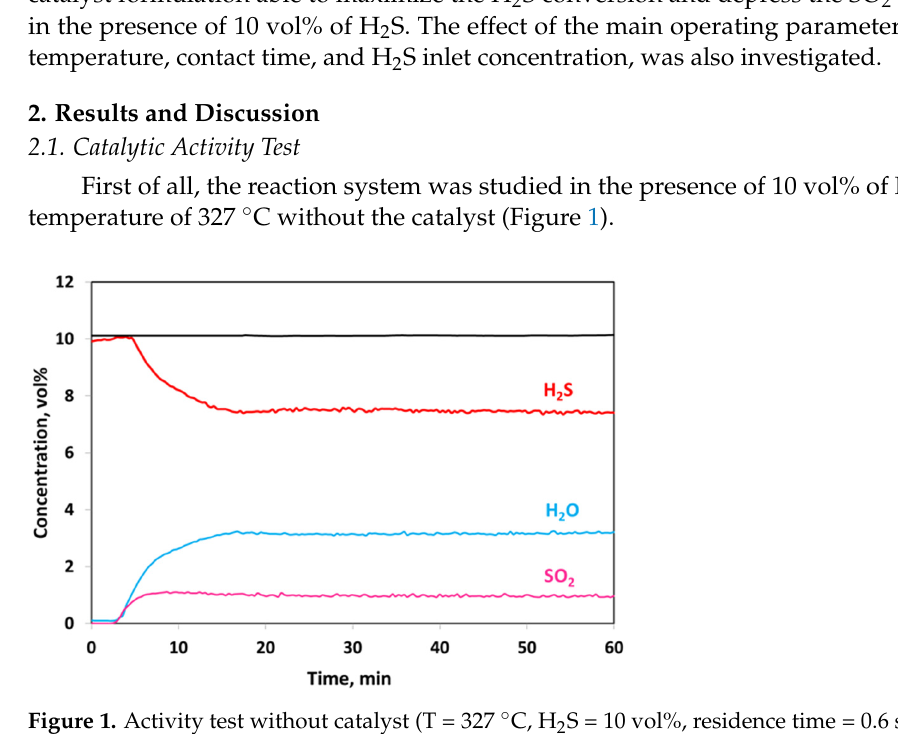
Figure 1. Activity test without catalyst (T = 327 °C, H 2 S = 10 vol%, residence time = 0.6 s).